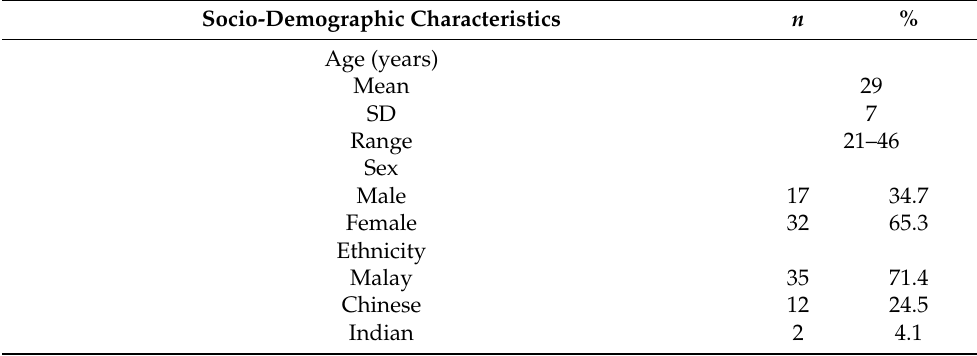
Table 3. Socio-demographic characteristics of subjects ( n =